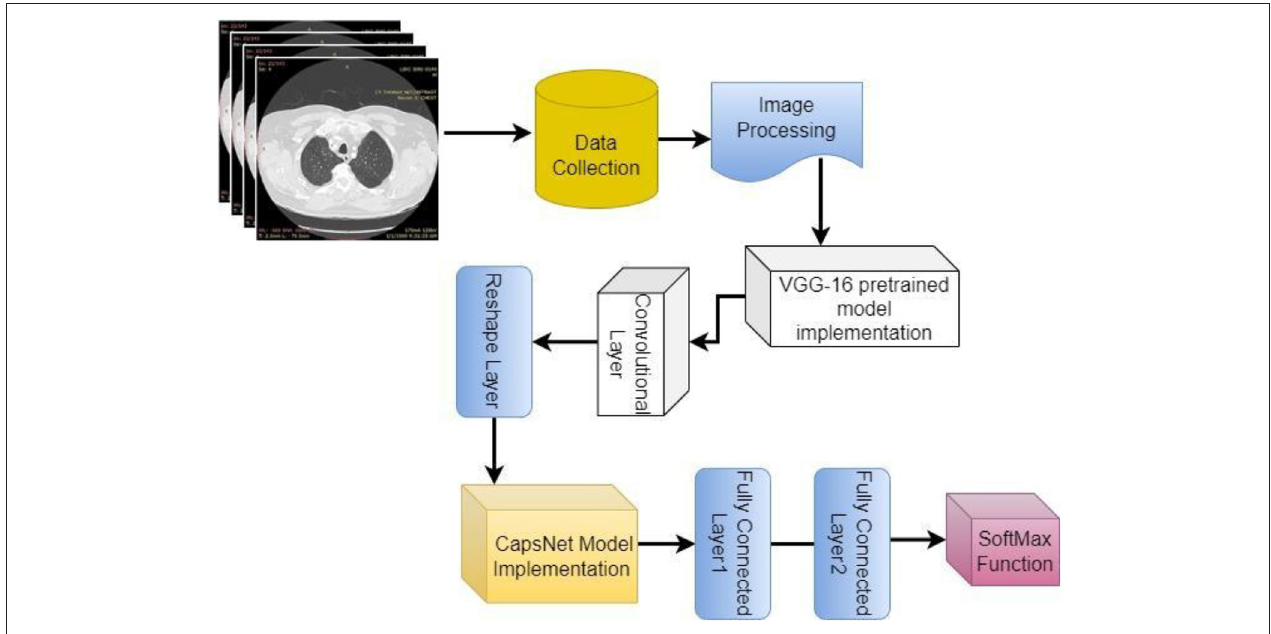
FIGURE 5 | Architecture of